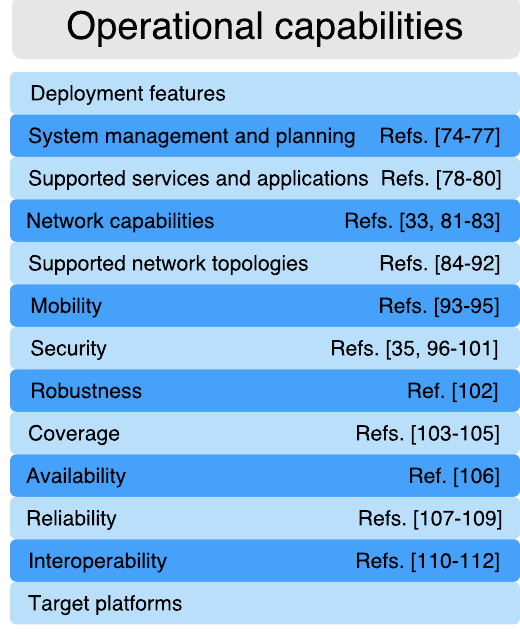
Figure 5. Operational Capabilities assessed to cover mission-critical